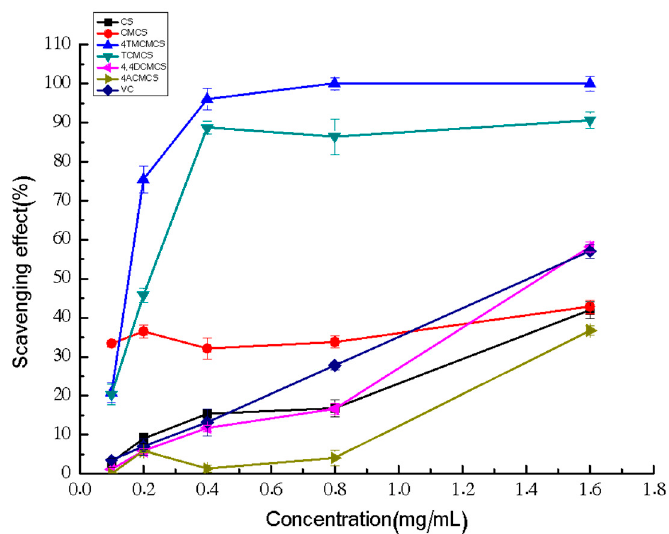
Figure 7. Hydroxyl radicals’ scavenging activity of CS, N, O-CMCS , and Carboxymethyl chitosan containing thiourea salts.